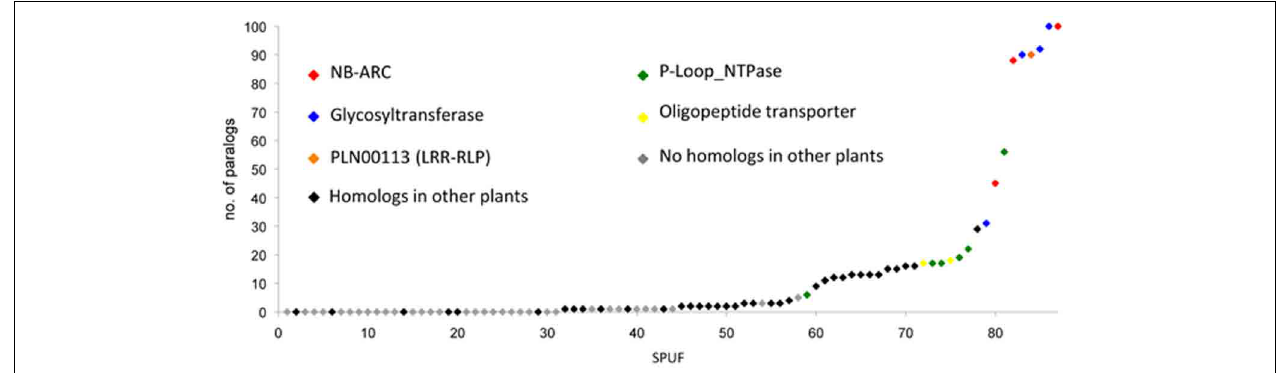
FIGURE 3 | Poplar SPUFs have limited paralogs and homologs in other plants. Poplar SPUF sequences were used for homology searches against the predicted poplar proteome on the Phytozome portal, as well as the